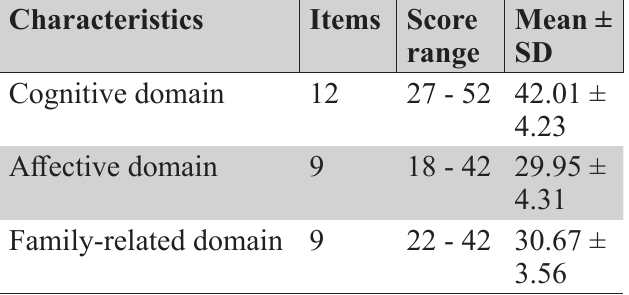
Table 2. Mean score of participants’ atitude based on FATCOD questionnaire (n=122).